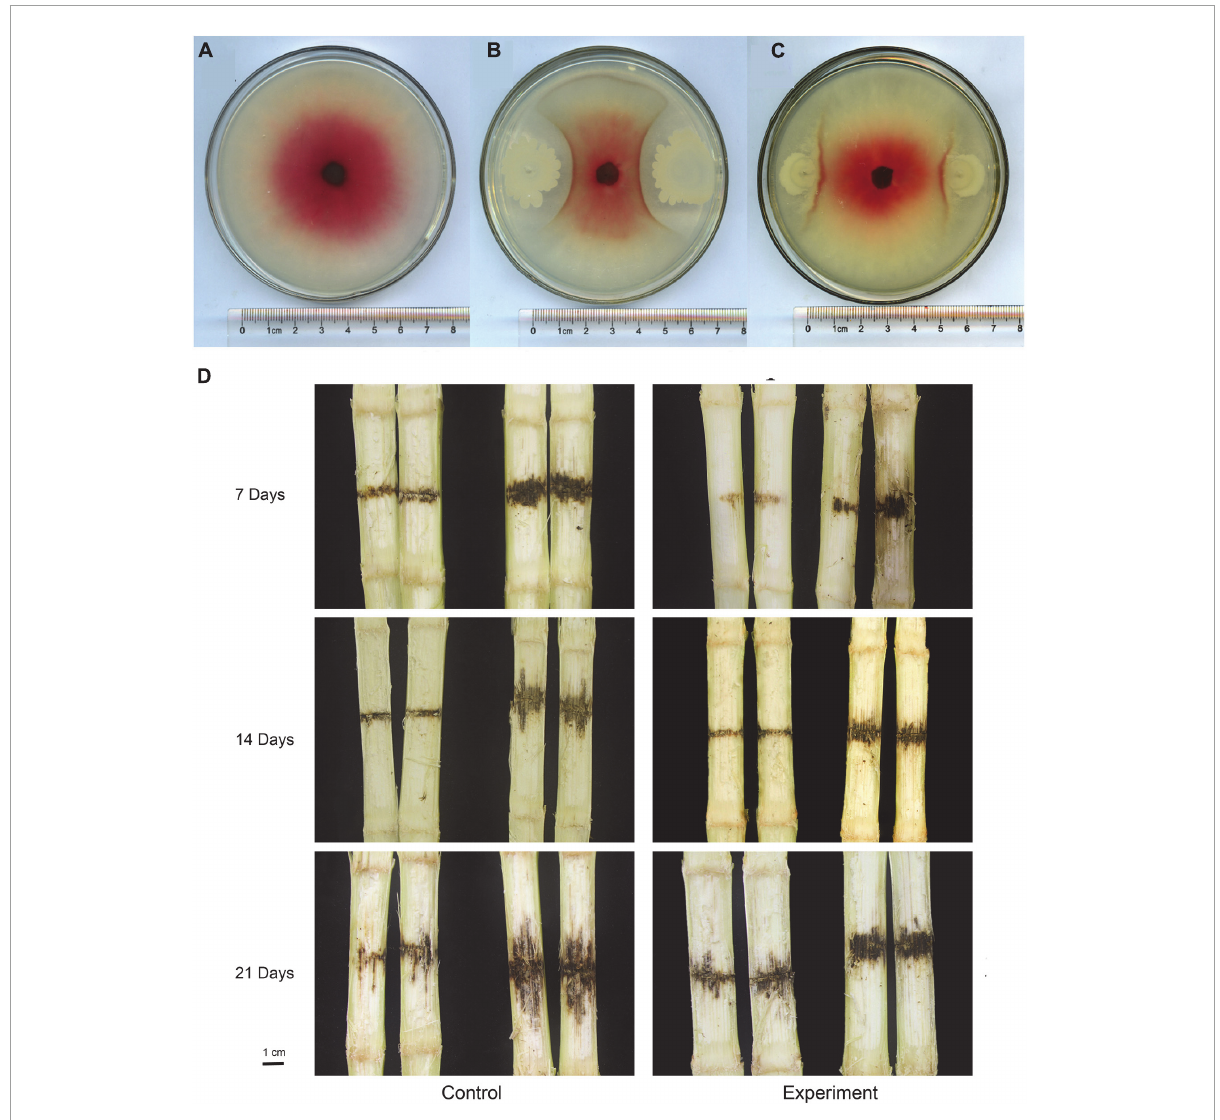
FIGURE7 In vitro competition assays with F. graminearum and B. siamensis GL-2 after 5 days of growth. F. graminearum control (A) , B. siamensis GL-02 and F. graminearum plated simultaneously (B) , B. siamensis GL-02 plate 2 days after F. graminearum inoculation (C) . Pathogenicity of F. graminearum after application of a B. siamensis GL-2 (D) . Left half of panel (D) depicts the maize stem that was not inoculated with F. graminearum , and the right half indicates the maize stem inoculated with F. graminearum